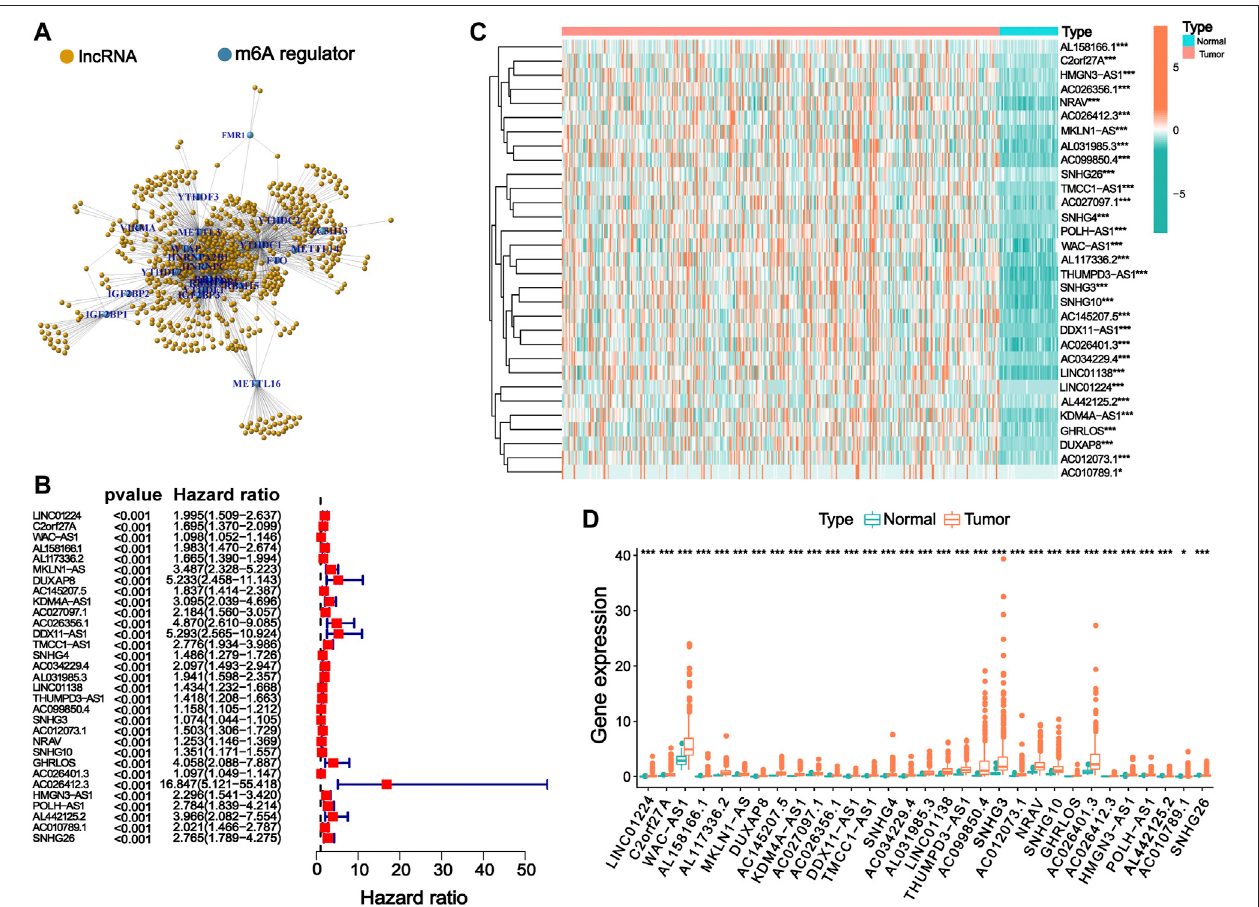
FIGURE 1 | Identi fi cation of m6ARlnc and prognostic m6ARlnc. (A) The co-expression network between m6A regulators and m6A regulator-related lncRNAs. (B) Forest plot of predictive ability of 31 prognostic lncRNAs associated with m6A regulators. (C) The heatmap of the expression of 31 m6A regulator-related prognostic lncRNAs incancerand normalgroups intheTCGA cohort(green:lowexpression level,red:high expression level). (D) Boxplot graphoftheexpression of31prognostic lncRNAs related to m6A regulators in the TCGA cohort (green: low expression level, red: high expression level; p -value was: *** p < 0.001, * p < 0.05).